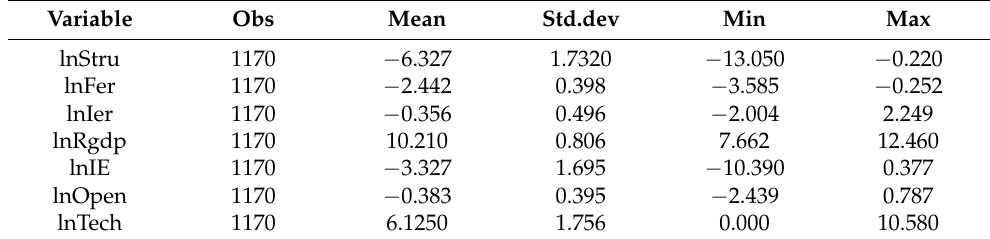
Table 1. Descriptive statistics for